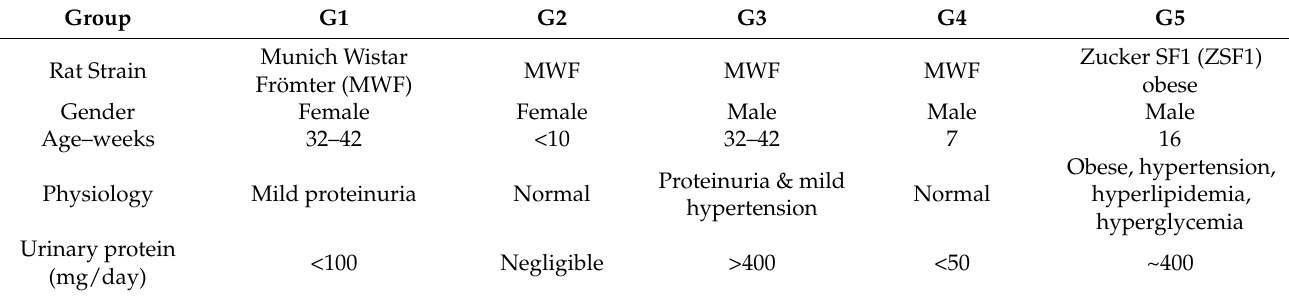
Table 1. Different specifications of five groups of